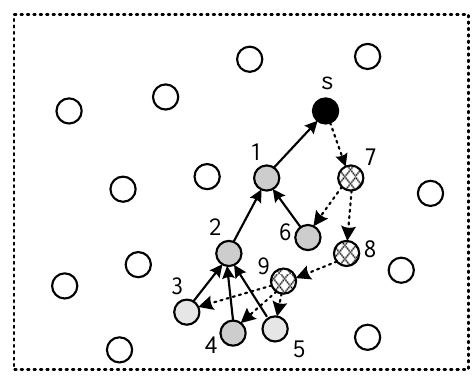
Figure 8. An example of the routing structure.